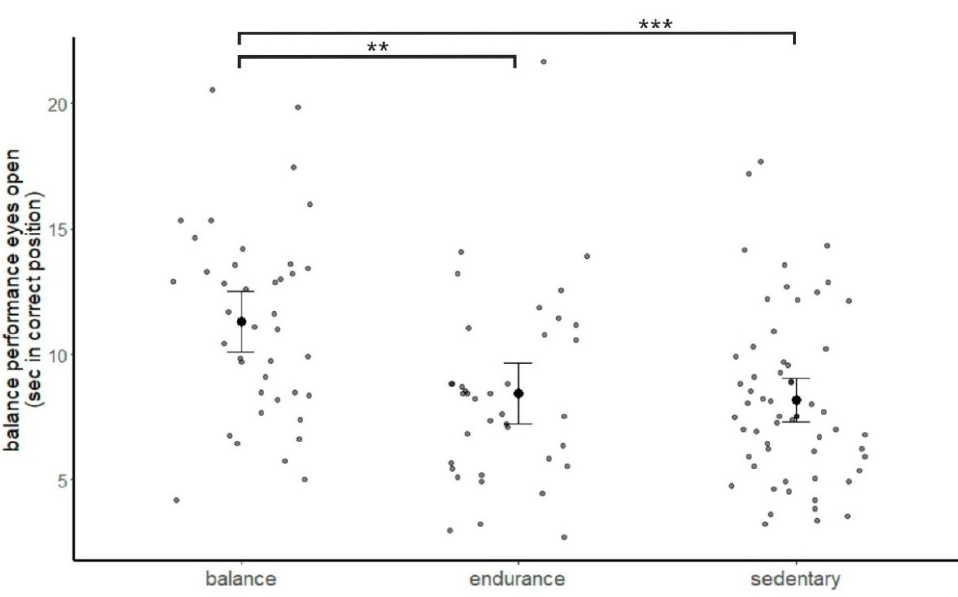
Table 1. Participant characteristics (Mean, Sd) for balance experts, endurance athletes and sedentary participants. Balance Experts